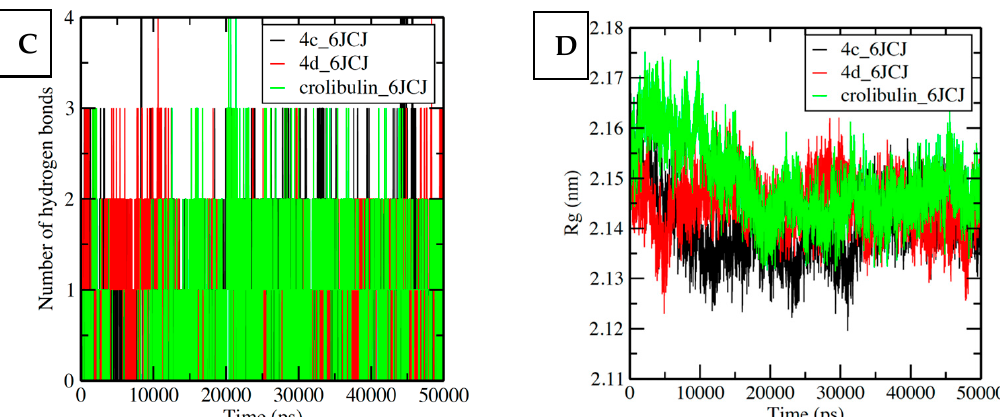
Figure 3. Molecular dynamics simulations of the 50 ns period: ( A ) RMSD plot of ligands ( 4c , 4d, and crolibulin)-tubulin (6JCJ) complexes. ( B ) RMSF plot of the selected complexes with fluctuation